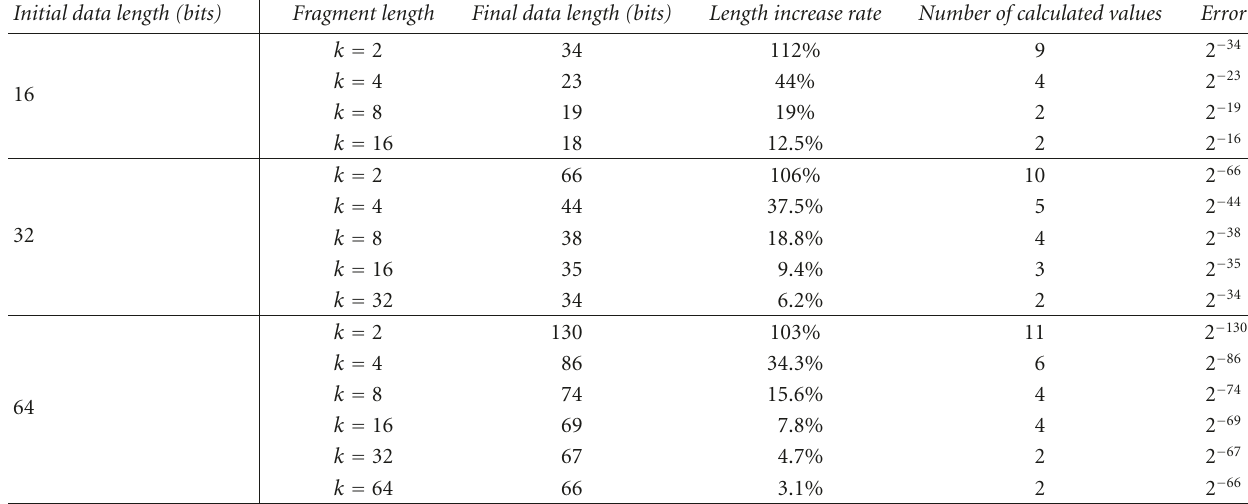
Table 7: Data length evolution and error versus number of calculated values for n = p = 16,32, and